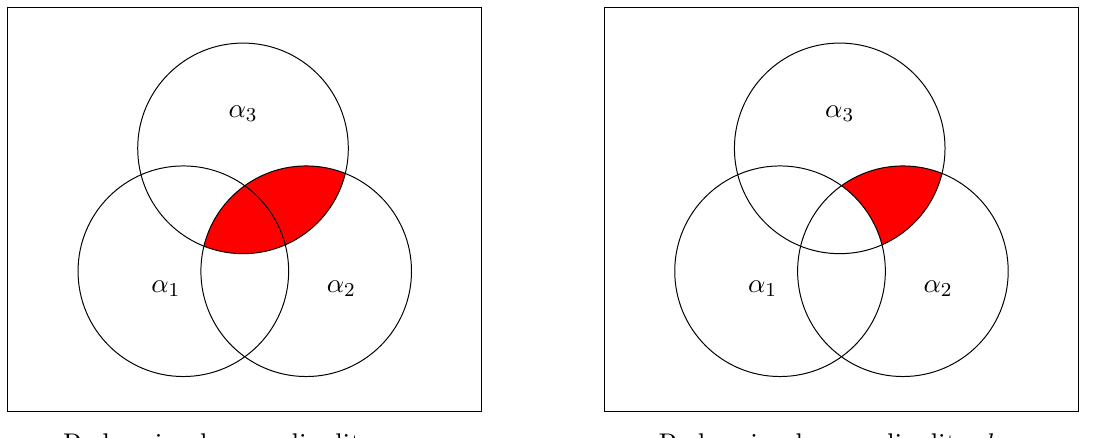
Figure 3 . Venn diagrams with three index sets. Each index set is represented by a circle, containing q elements. The box is the set of all possible values an index can take, which has cardinality N . The box is partitioned into eight